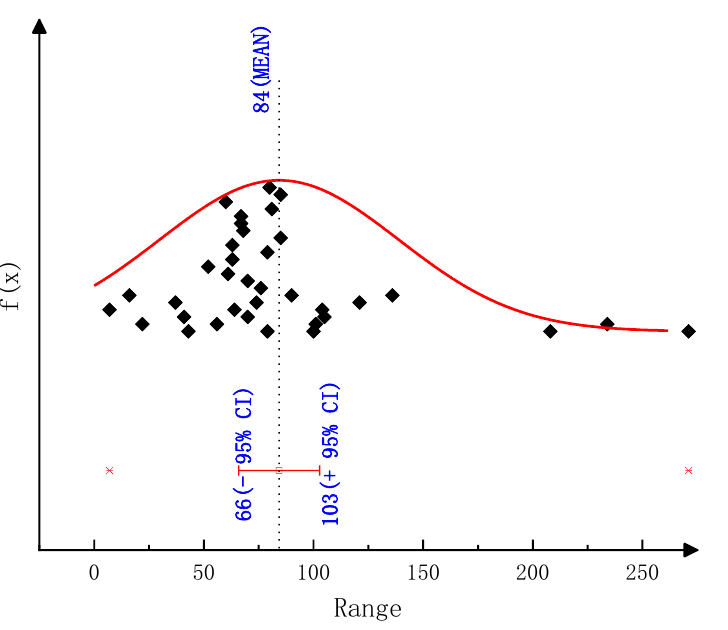
Figure A3. 95% confidence interval for the activation energy E F,1 of urea pyrolysis reaction.